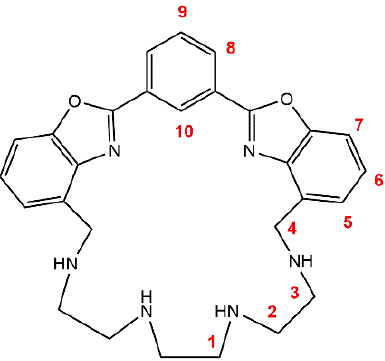
Figure 1. Structure of ligand L together with 1 H NMR labelling scheme.